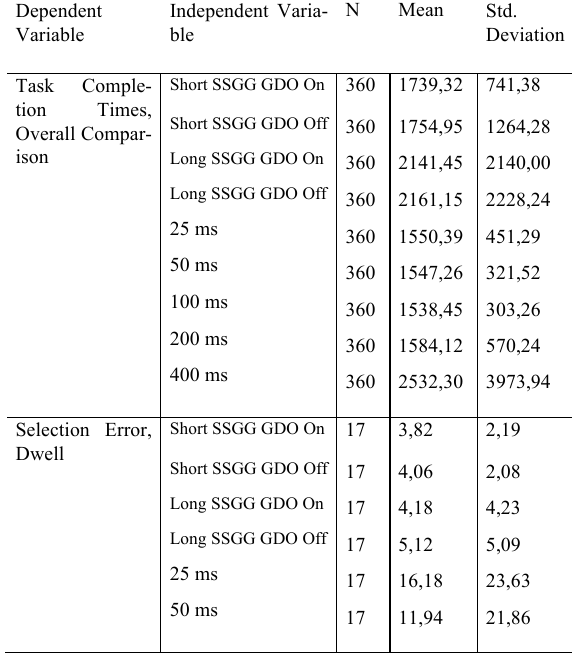
Descriptive Statistics for Overall Task Completion